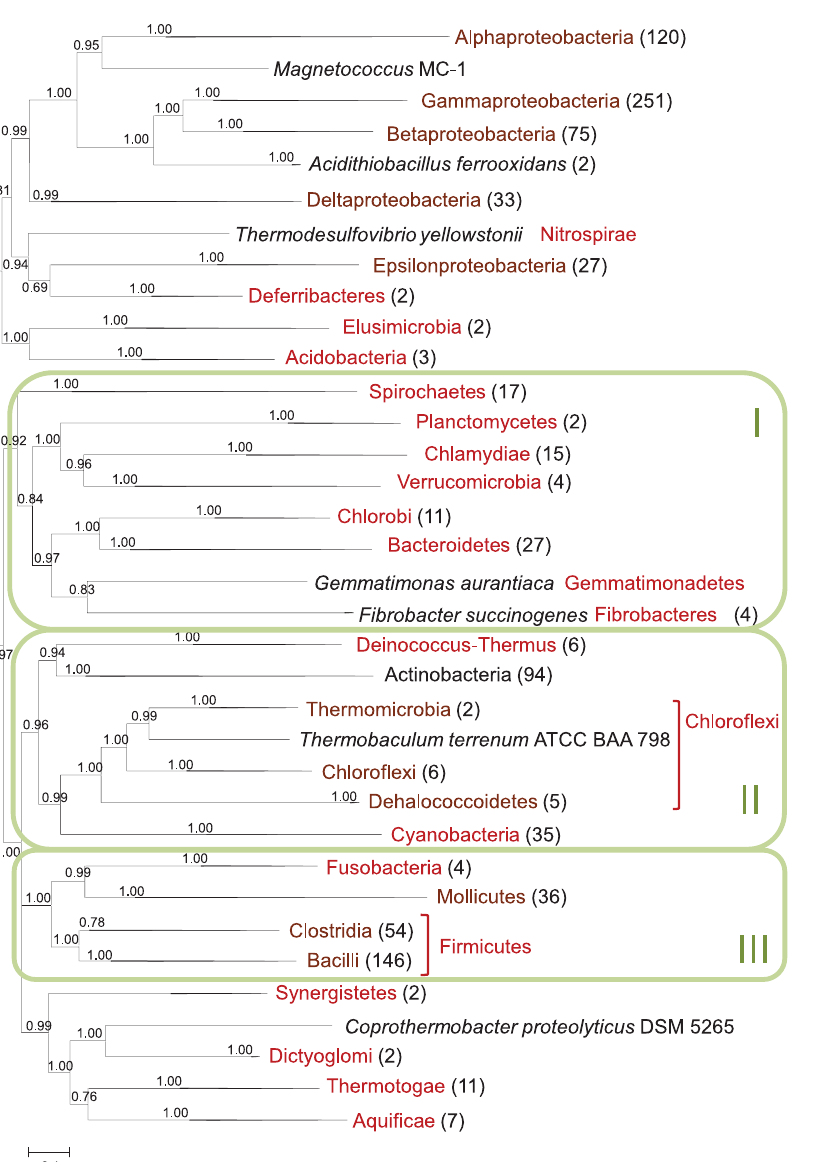
Figure 2. Bacterial phylogenetic tree reconstructed from a concatenated alignment of 50 nearly ubiquitous r-proteins. Green boxes denoted as I, II, and III mark three putative ‘‘megaphyla’’ discussed in the text. Branches having bootstrap support values less than 0.5 were